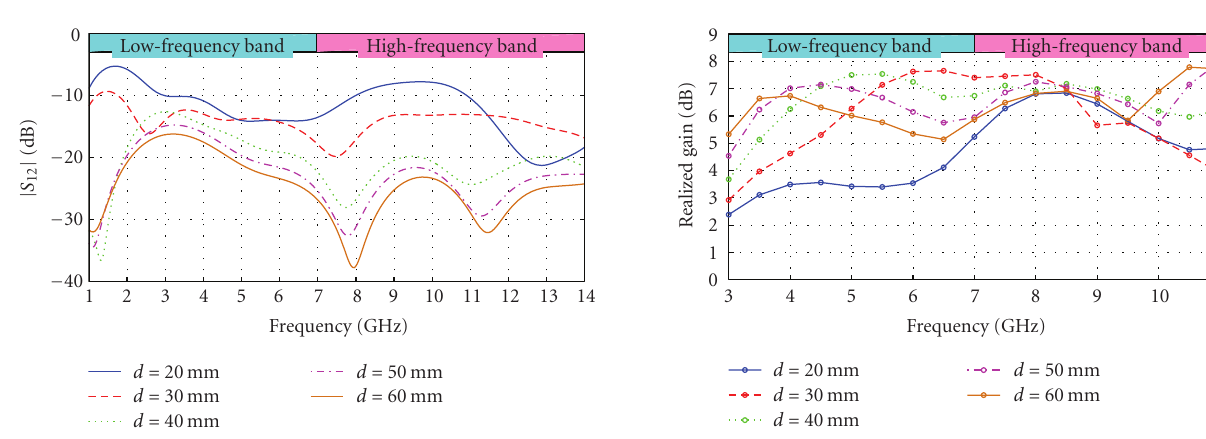
Figure 7: Simulated realized gain results of two-element UWB array.